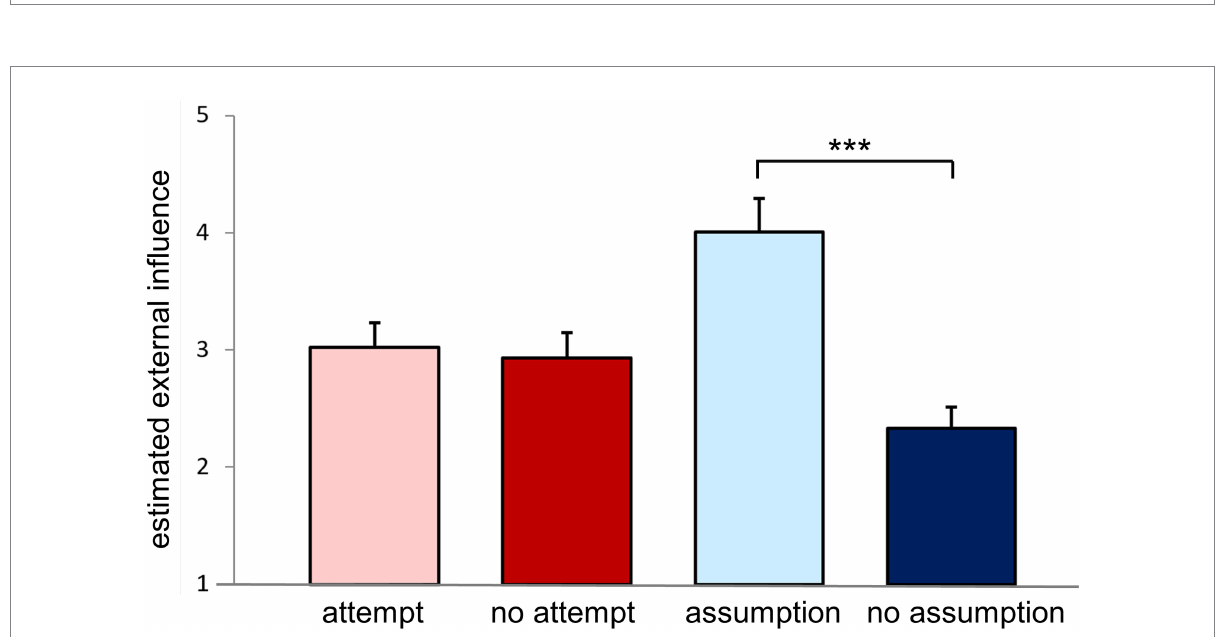
FIGURE 5 External influence estimation during the “setup & 50% condition.” During the “setup & 50% condition” participants were informed that external influence will be attempted in 50% of the trials but no information was provided regarding each specific trial. 24 trials were carried out. The bar graph shows estimated external influence depending on interventional condition [trials with “attempt” of external influence (light red) vs. trials with “no attempt” of external influence (dark red)] and responses of the participants [“assumption” of external influence (light blue) vs. “no assumption” of external influence (dark blue)]. It should be noted that the number of trials was fixed regarding interventional conditions ( n = 12 attempt, n = 12 no attempt), whereas assumptions of external influence varied considerably between subjects [ n = 0–15 assumption (mean 10.0 ± 4.1), n = 9–24 no assumption (mean 14.0 ± 4.1)]. *** p ≤ 0.001. Mean values and standard error of the means are